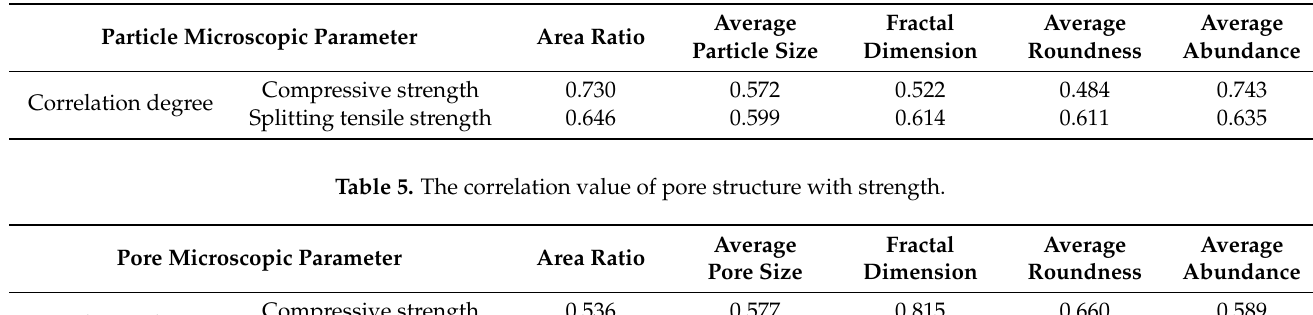
Table 4. The correlation value of particle morphology with strength.